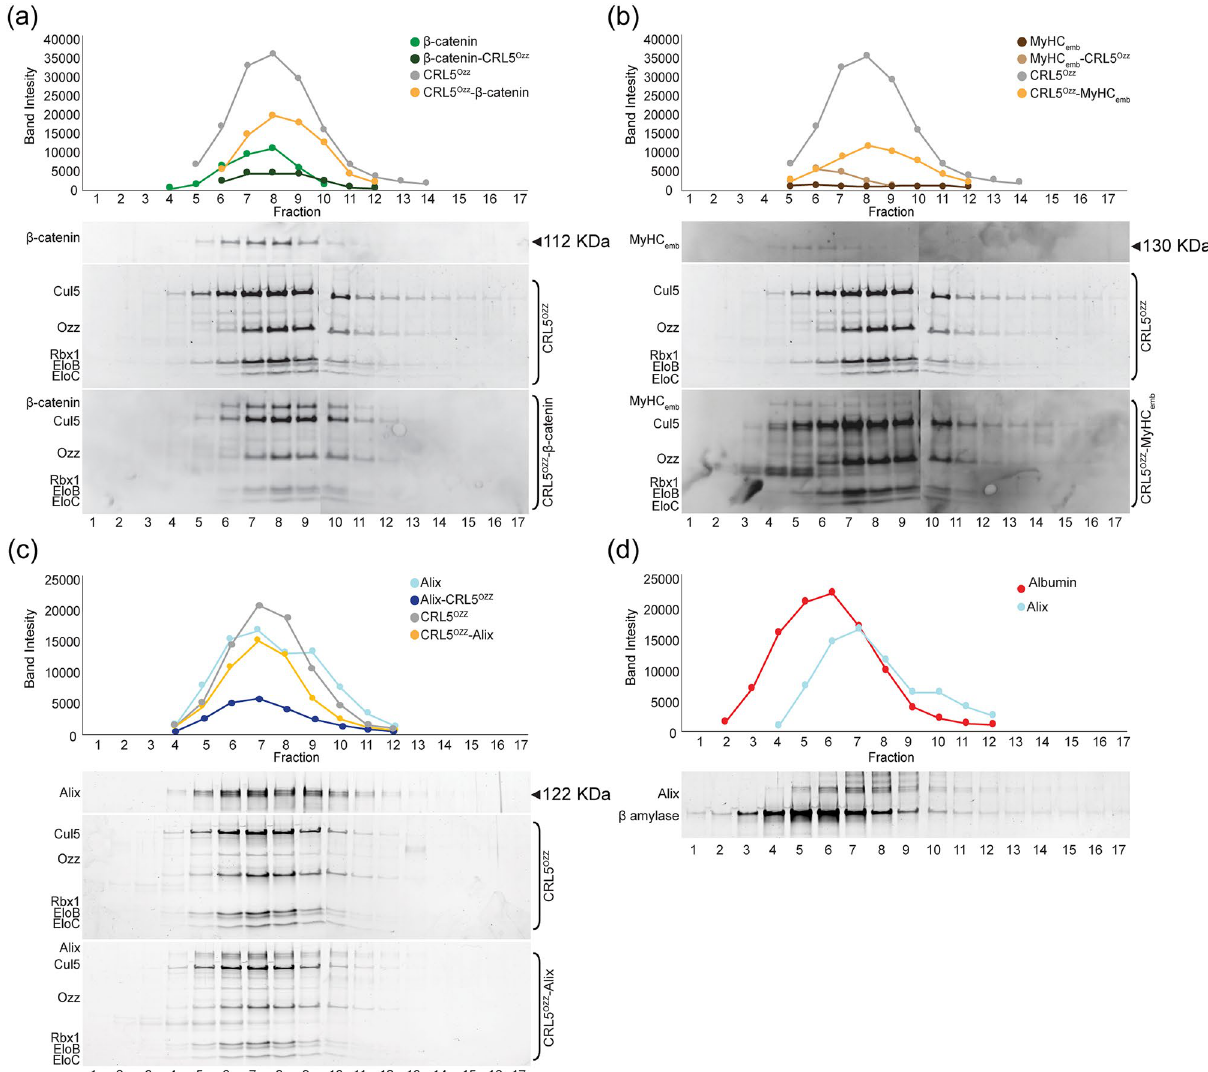
Figure 6. Glycerol gradient ultracentrifugation microfractionation analysis of CRL5 Ozz and its substrates. Assembled CRL5 Ozz mixed with purified preparations of ( a ) GST- full length β-catenin, ( b ) GST-MyHC emb fragment (1041–1941 a.a.) and ( c ) GST-full length Alix was fractionated from a post-ultracentrifuged glycerol gradient (8 h). Aliquots of each fraction were separated on SDS–polyacrylamide gels and their protein content visualized on gels stained with SYPRO Ruby. The densitometric measurement of band intensity of the proteins in each fraction showed a shift to a higher molecular weight when CRL5 Ozz was mixed with either of its substrates, compared to the molecular weights of CRL5 Ozz or its individual substrates: CRL5 Ozz –β-catenin (~ 272 kDa), CRL5 Ozz –MyHC emb fragment (1041–1941 a.a.) (~ 280 kDa) or CRL5 Ozz –Alix (~ 282 kDa). ( d ) Sedimentation analysis of Alix mixed with albumin as internal control. The fractions were loaded on an SDS– polyacrylamide gel and stained SYPRO Ruby. Alix and albumin were visible in fractions 2–12 and the profile of either protein was not altered in presence of the